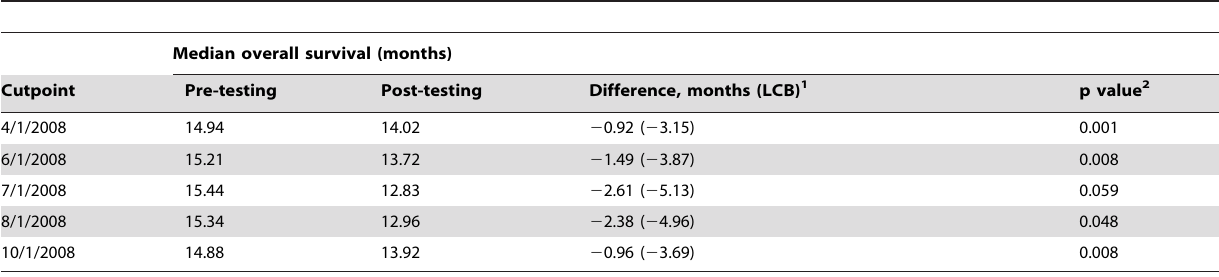
Table 5. Sensitivity analysis showing unadjusted non-inferiority test results for overall survival (OS) using different dates to specify pre- and post-testing groups for adoption of KRAS